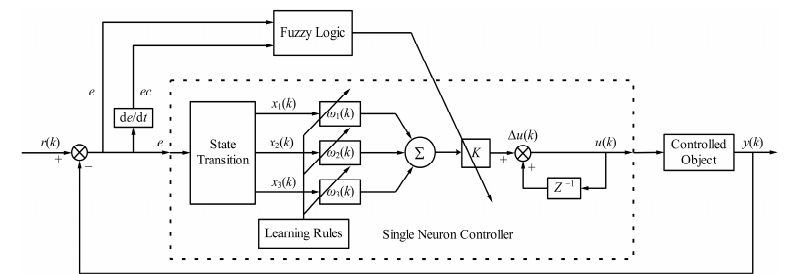
Figure 3. The structure of FSNNN PID control algorithm.